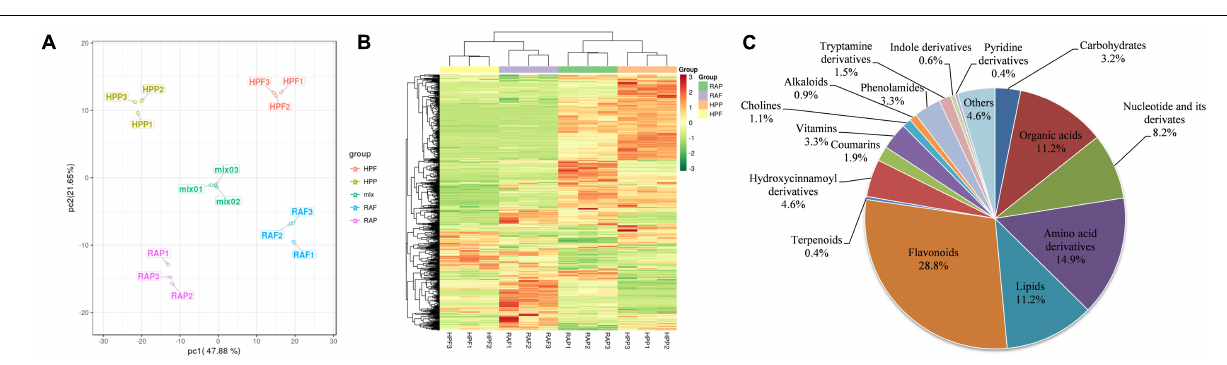
FIGURE 2 | Cluster analysis for all sample data. (A) Principal component analysis of the peel and flesh of two kumquat fruits and the mixed samples. (B) Hierarchical cluster analysis of all metabolites detected in the peel and flesh of RA and HP samples. Content of a metabolite was normalized by the range method. Each example is visualized in a single column, and each metabolite is represented by a single row. (C) Categories and proportion of all identified